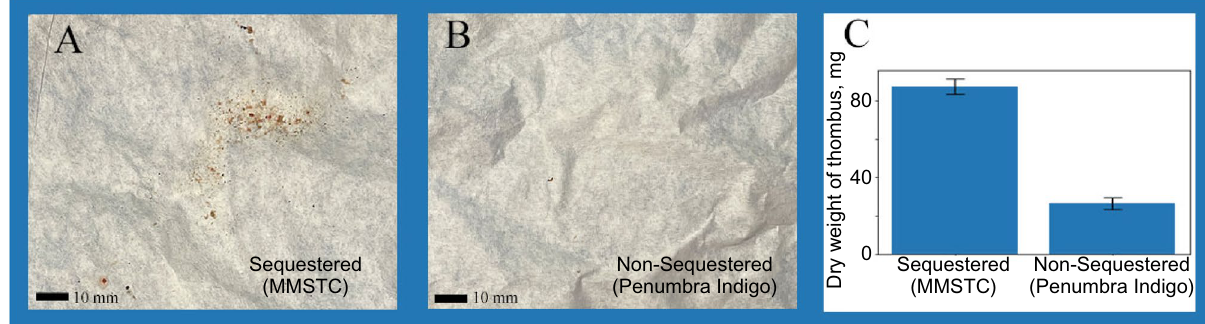
Figure 5. ( A ) Thrombus evacuated by the MMSTC in a typical experiment, viewed on filter paper, over the course of a 30 s treatment within the flow system. ( B ) Thrombus evacuated by the Penumbra Indigo CAT 5 Fr catheter in a typical experiment, viewed on filter paper, over the course of a 30 s treatment within the flow system. ( C ) The MMSTC evacuated significantly more thrombus than the Penumbra Indigo CAT 5 Fr catheter under these conditions ( p = 0.005